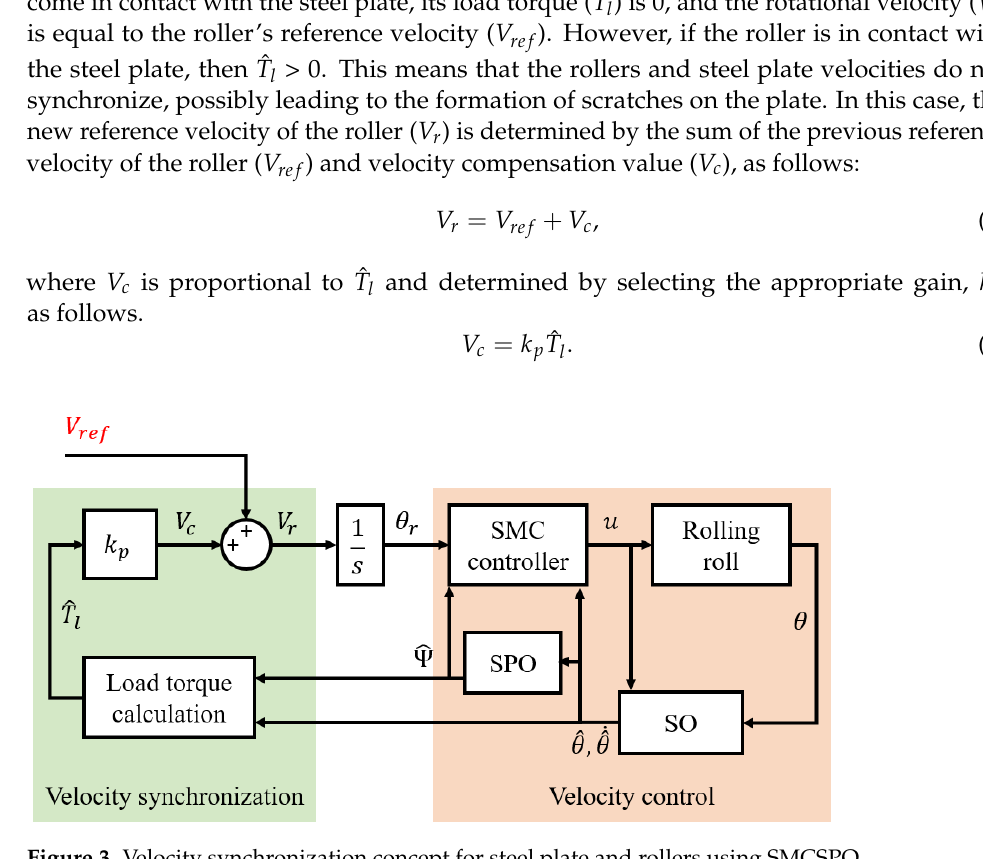
Figure 3. Velocity synchronization concept for steel plate and rollers using SMCSPO. The velocity synchronization method for the rollers and steel plates can be imple- mented by selecting a suitable k p